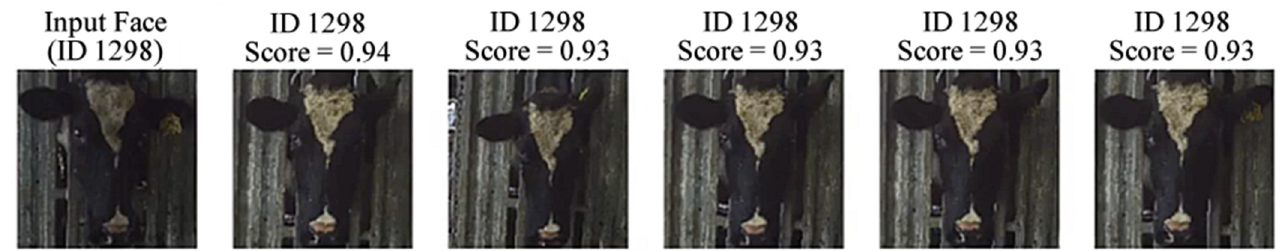
Figure 5. Example of input target face (first on the left) in a search returned top five most similar faces in the database.